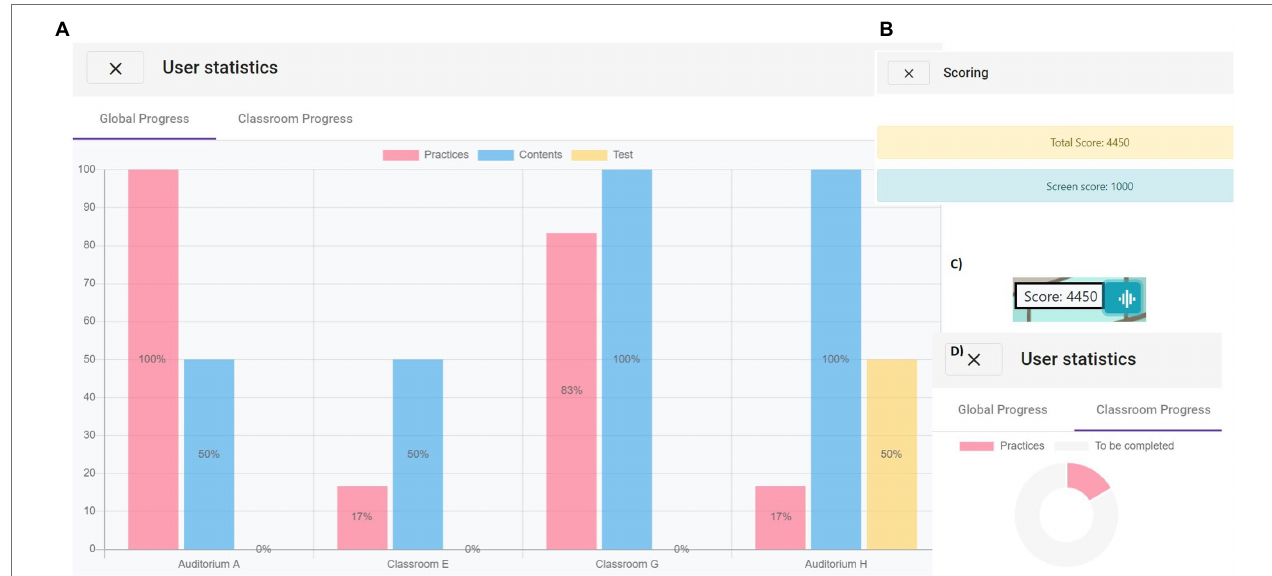
FIGURE 10 | Scoring: (A) global scoring and button to access the global and local scoring; (B) global and local scoring; (C) a set of three bars is presented for each of the room, with the information about practices (red), units of learning (blue) and tests (yellow); and (D) for the current room, a doughnut chart is shown for each of the